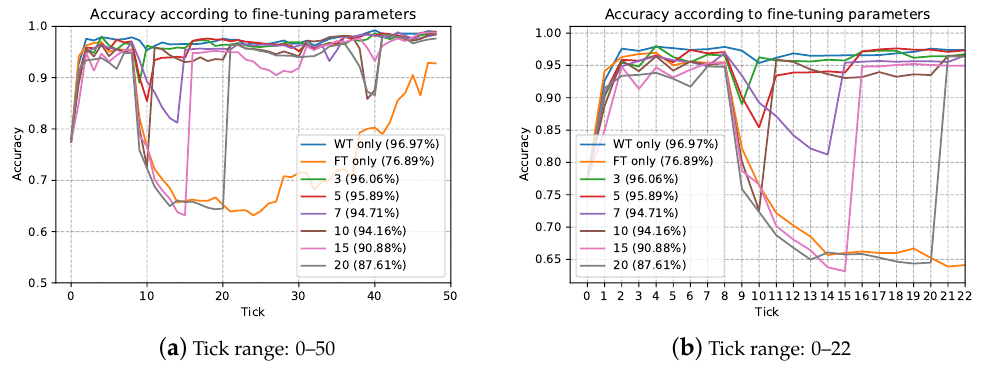
Figure 9. Model accuracy according to update